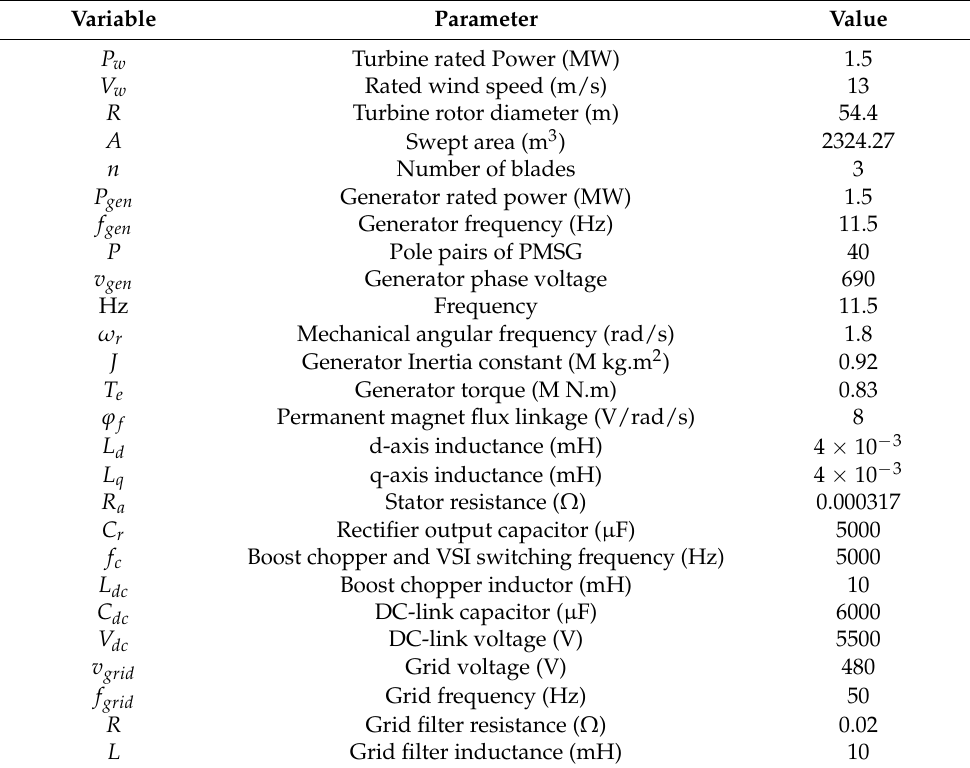
Table 2. Rated parameters of the WECS considered for